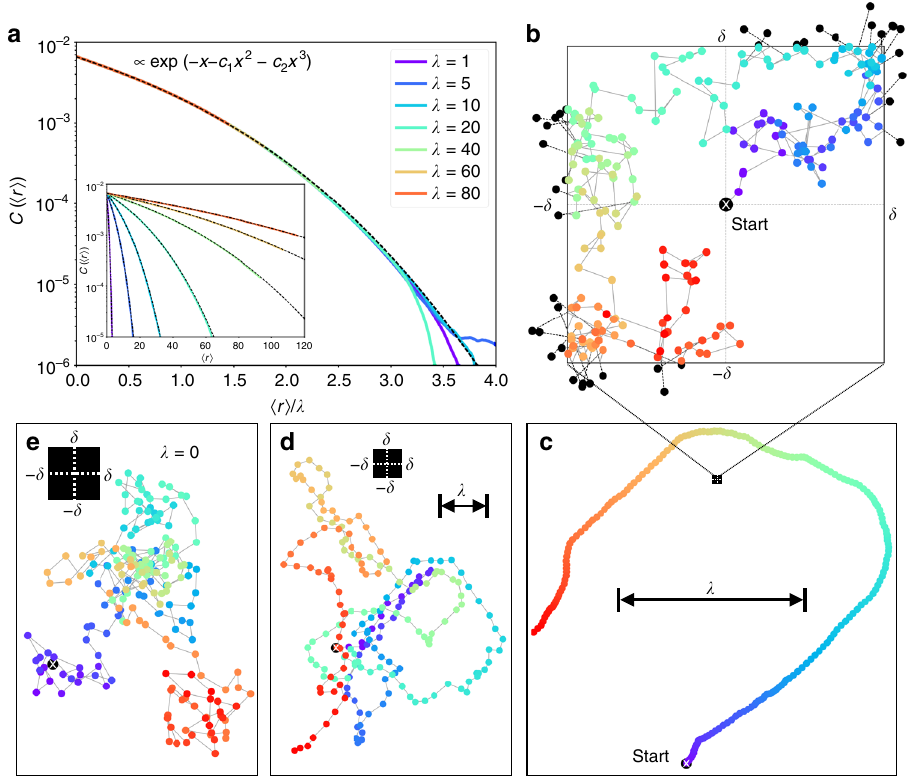
Fig. 1 Kinetic Monte Carlo algorithm. a Autocorrelation of proposed displacements as a function of the covered distance for a single 2D active particle. The data collapse for widely different activities allows the de fi nition of a persistence length λ (see Methods) (see inset for raw data without rescaling). b Time evolution of proposed displacements in a box of size [ − δ , δ ] 2 . The displacement є ( t ) is sampled from a bivariate normal distribution with standard deviation σ (here σ (cid:1) δ ), centred at the previous displacement є ( t − 1). Positions sampled outside the box (black points) are folded back, implementing the P t є ( k ), with the corresponding history of displacements from ( b ). re fl ecting boundary condition (see Methods). c Trajectory for a single particle r ð t Þ ¼ k ¼ 1 The colour gradient changing with time allows to connect ( b , c ), e.g. the last displacements in b are in the third quadrant thus the particle in c moves to the lower left etc. c – e Sampled trajectories, illustrating the transition from a passive random walk ( σ (cid:3) δ in e ) to a persistent random walk ( σ (cid:1) δ in c